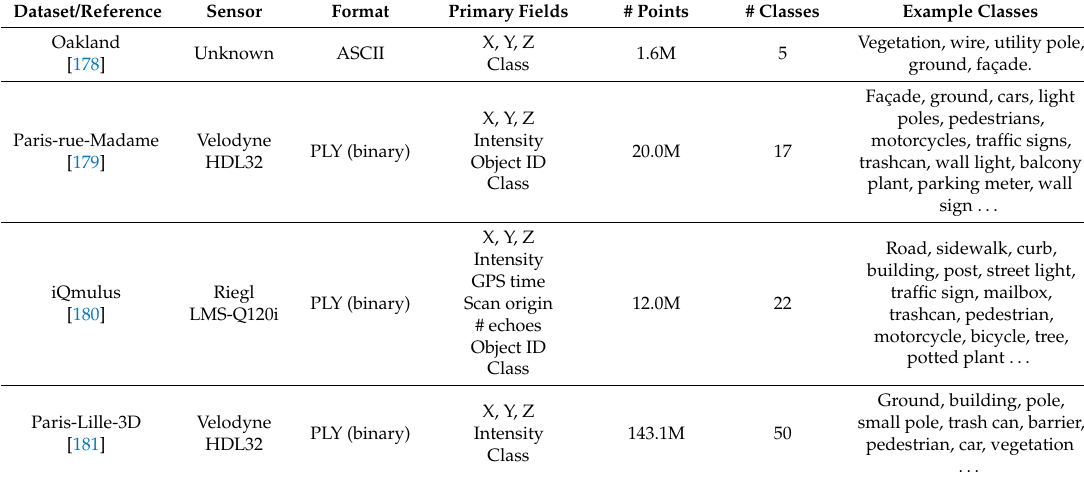
Table 9. Benchmark datasets for classification of MLS